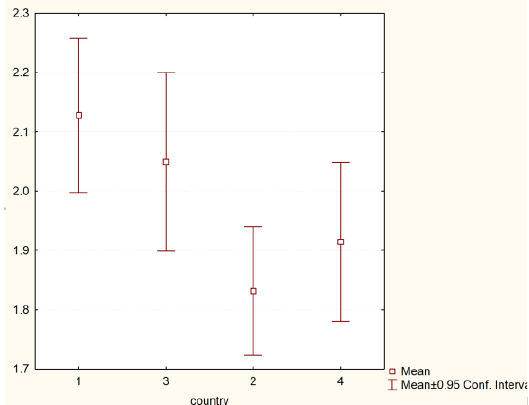
Figure 4. Risky behaviourso of students and the country of origin (H = 11.30513 p = 0.0102). Leg- end: 1 — Poland, 2 — Hungary, 3 — Greece, 4 — Turkey.